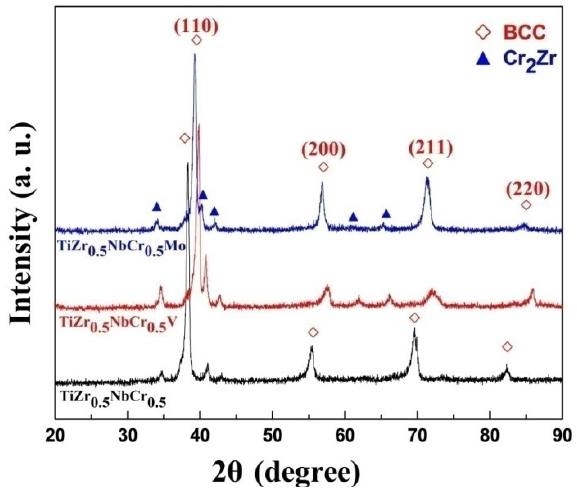
Figure 1. XRD patterns of the as-solidified TiZr 0.5 NbCr 0.5 , TiZr 0.5 NbCr 0.5 V and TiZr 0.5 NbCr 0.5 Mo alloys.